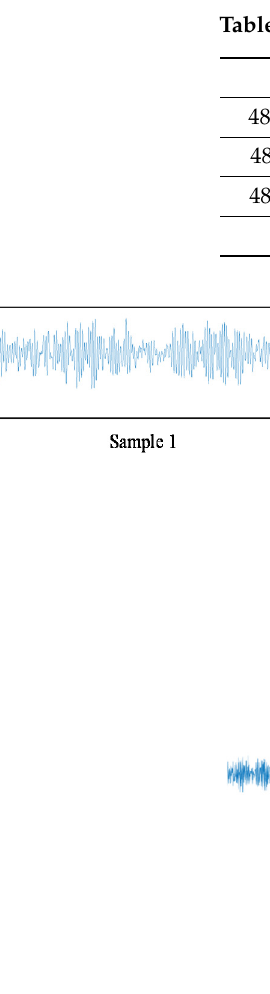
Table 2. Length of train, test, and validation set used in the research.